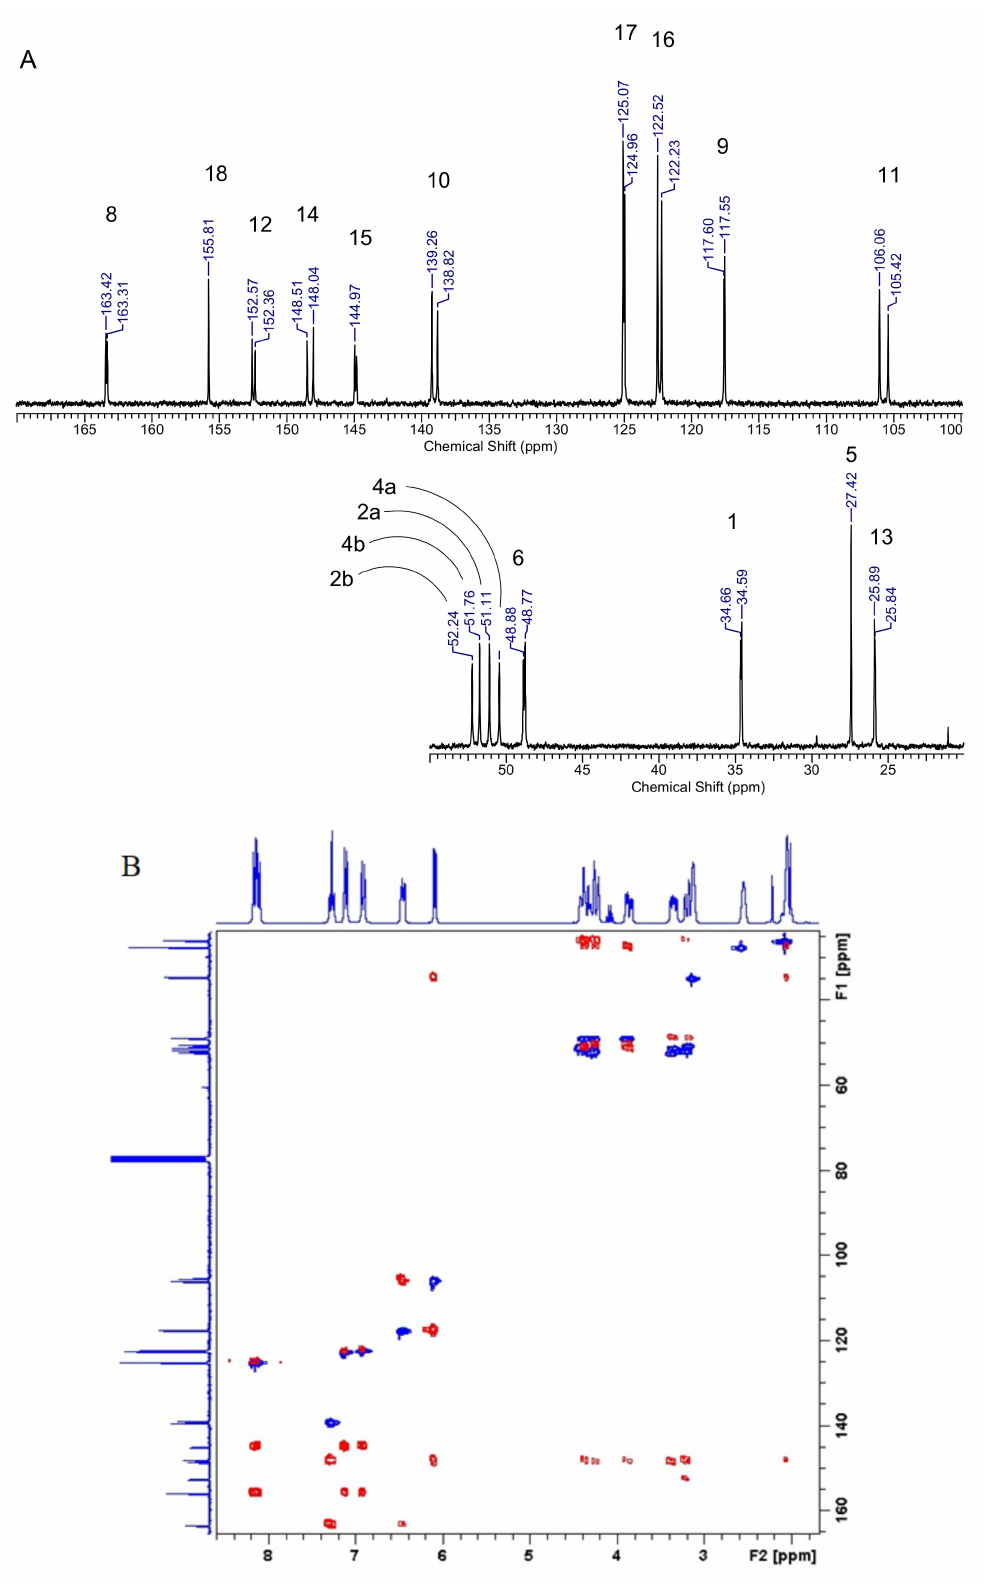
Figure 3. 13 C-NMR spectrum of CNPC in CDCl 3 (two relevant fragments of the spectrum are presented in trace ( A ) and HSQC-HMBC combined 2-D map ( B ): Blue cross-peaks represent HSQC, and red cross peaks correspond to HMBC